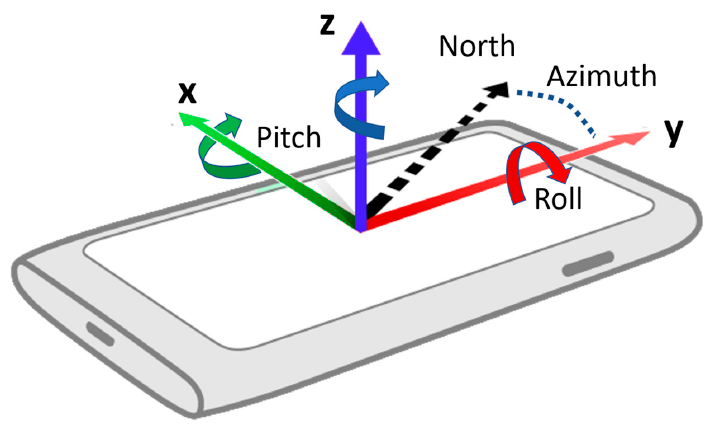
Figure 11. Illustration of the roll, pitch, and azimuth compared to the north direction.